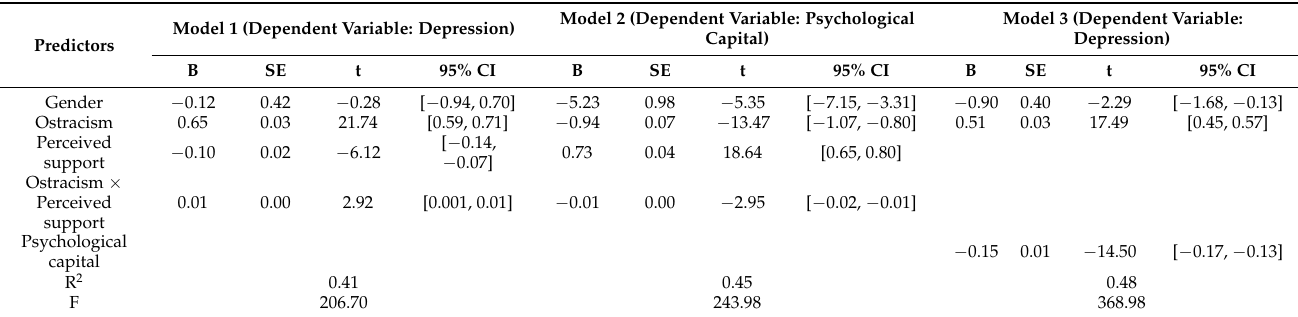
Table 3. Testing the moderated mediation effect of perceived support on the association between ostracism and depression via psychological capital.